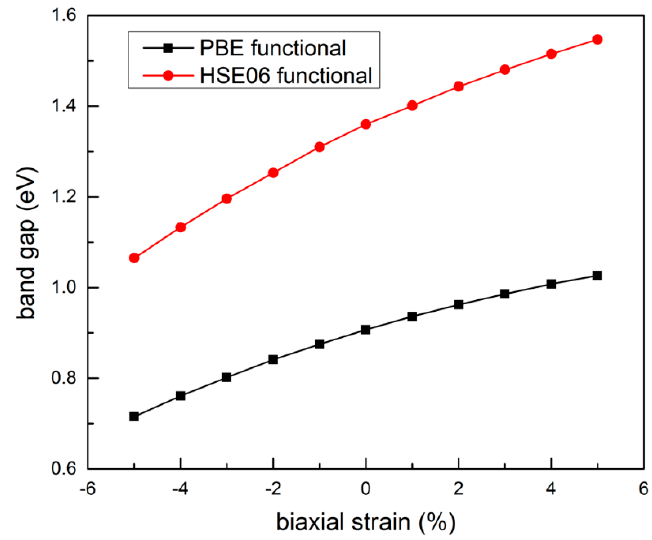
Figure 7. Band gap of pure boron-phosphide monolayer as a function of biaxial strain.